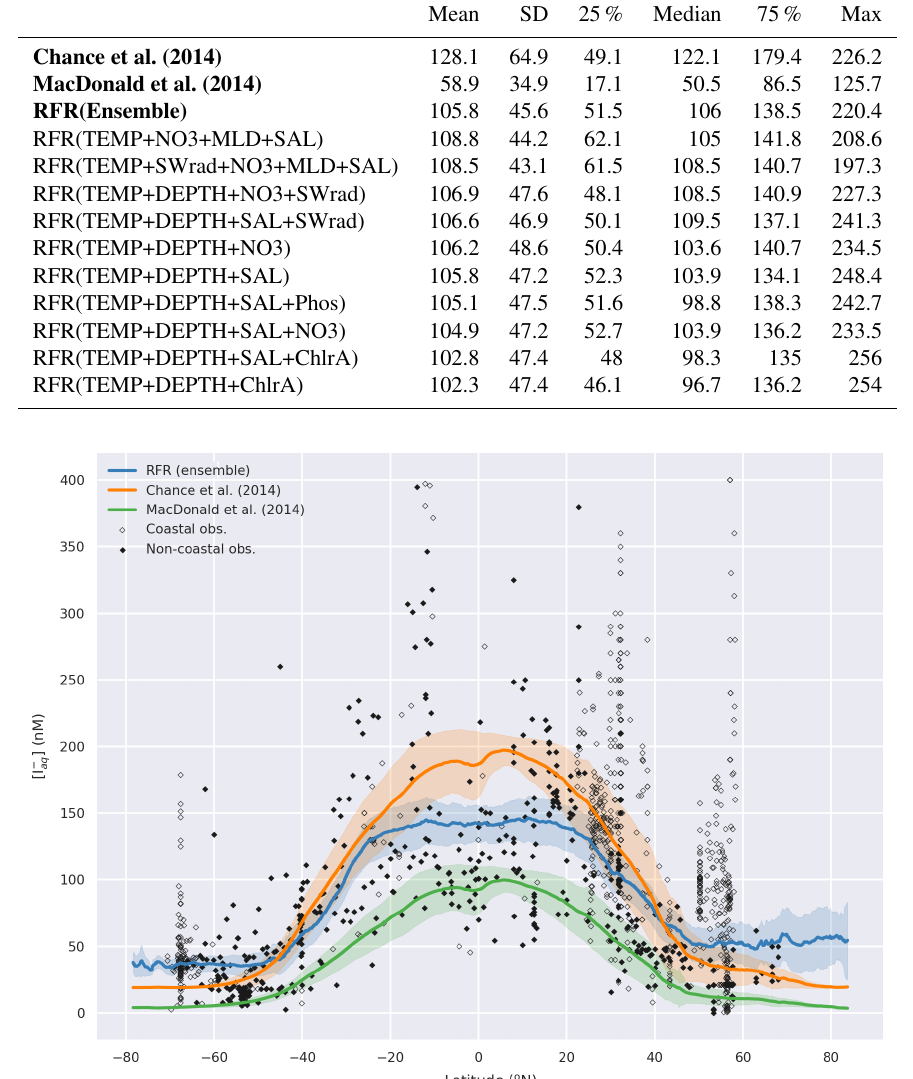
Figure 7. Predicted annual average sea-surface iodide plotted against latitude (lines), overlaid with observed concentrations (diamonds). Solid lines give mean values and shaded regions give ( ± ) the average standard deviation. The standard deviation is the monthly standard deviation across a latitude between all 10 ensemble members (RFR(Ensemble)) or within a single prediction for existing parameterisations (Chance et al., 2014; MacDonald et al., 2014). Filled diamonds show non-coastal observations and non-filled ones show coastal values. Extent of x axis is shown for grid boxes that are entirely